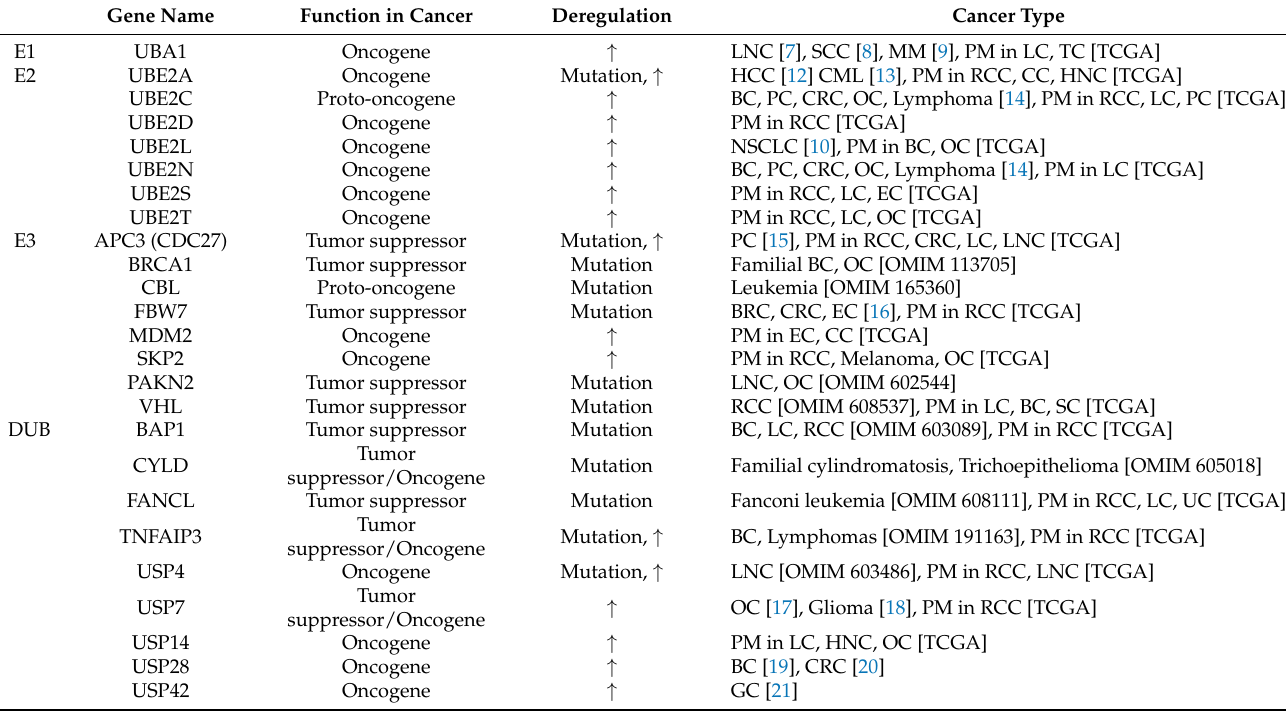
Table 1. Examples of cancer-related UPS enzymes. The relevant cancer type information for each gene referenced OMIM (https://www.ncbi.nlm.nih.gov/omim) (accessed on 7 March 2022) or The Cancer Genome Atlas